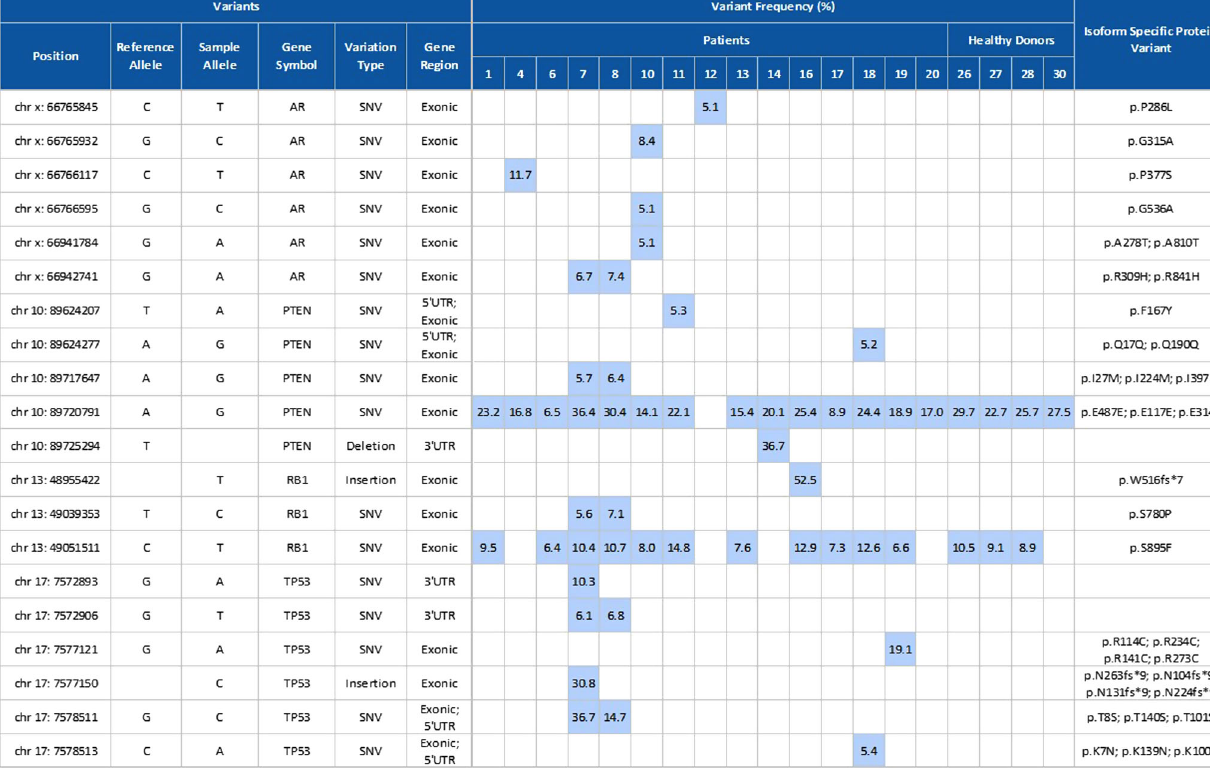
Fig. 6 Variants and variant frequencies identi fi ed in samples isolated from PC patients and age-matched healthy donors. DNA was extracted from cells and subjected to the multiplex PCR using the GeneRead DNAseq Prostate Cancer Mix and Match Panel, enabling enrichment of the coding regions and exon/intron junctions of four genes: AR, PTEN, RB1, and TP53. Variant frequency of the detected mutation is highlighted in light